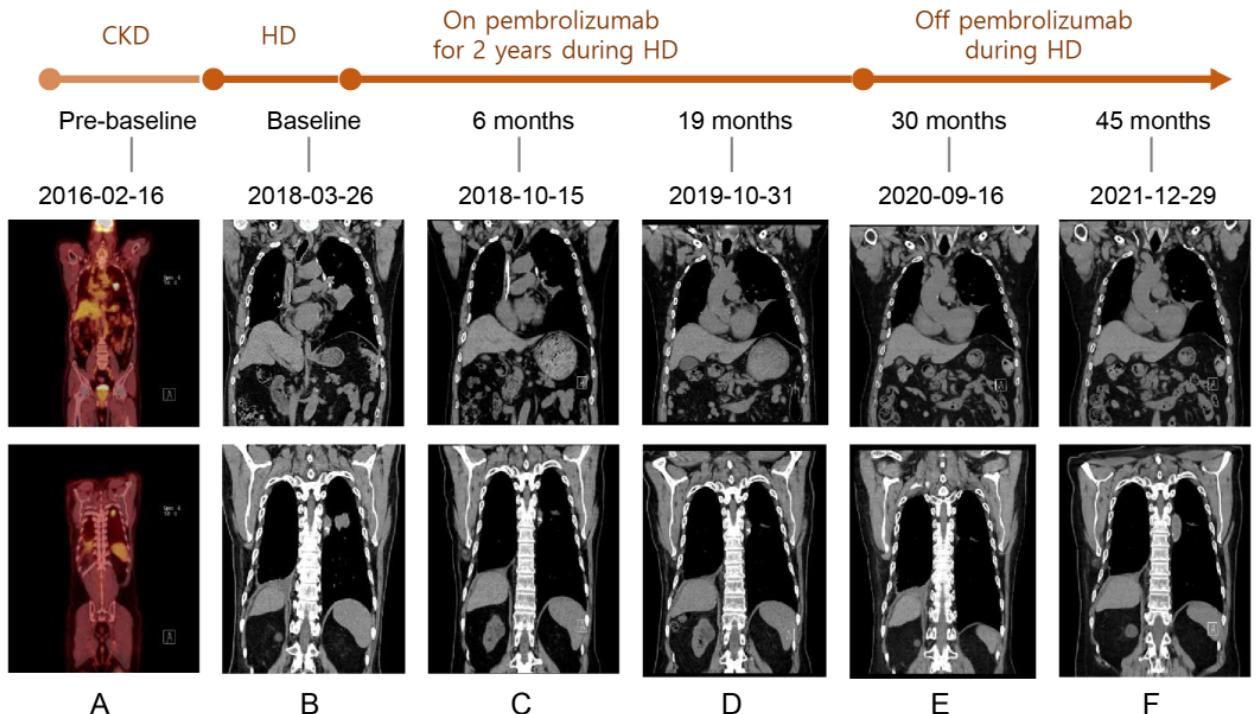
Figure 1. [F-18]FDG PET/CT scan and serial CT scans of the chest before and after pembrolizumab administration. ( A ) The [F-18]PET/CT scan on 16 February 2016 showed [F-18]FDG uptake in metastatic nodules in left upper lobe and left lower lobe. ( B – F ) The CT scans serially showed decreased extent of metastases in left lower lobe and left lower lobe from 26 March 2018 to 29 December 2021.